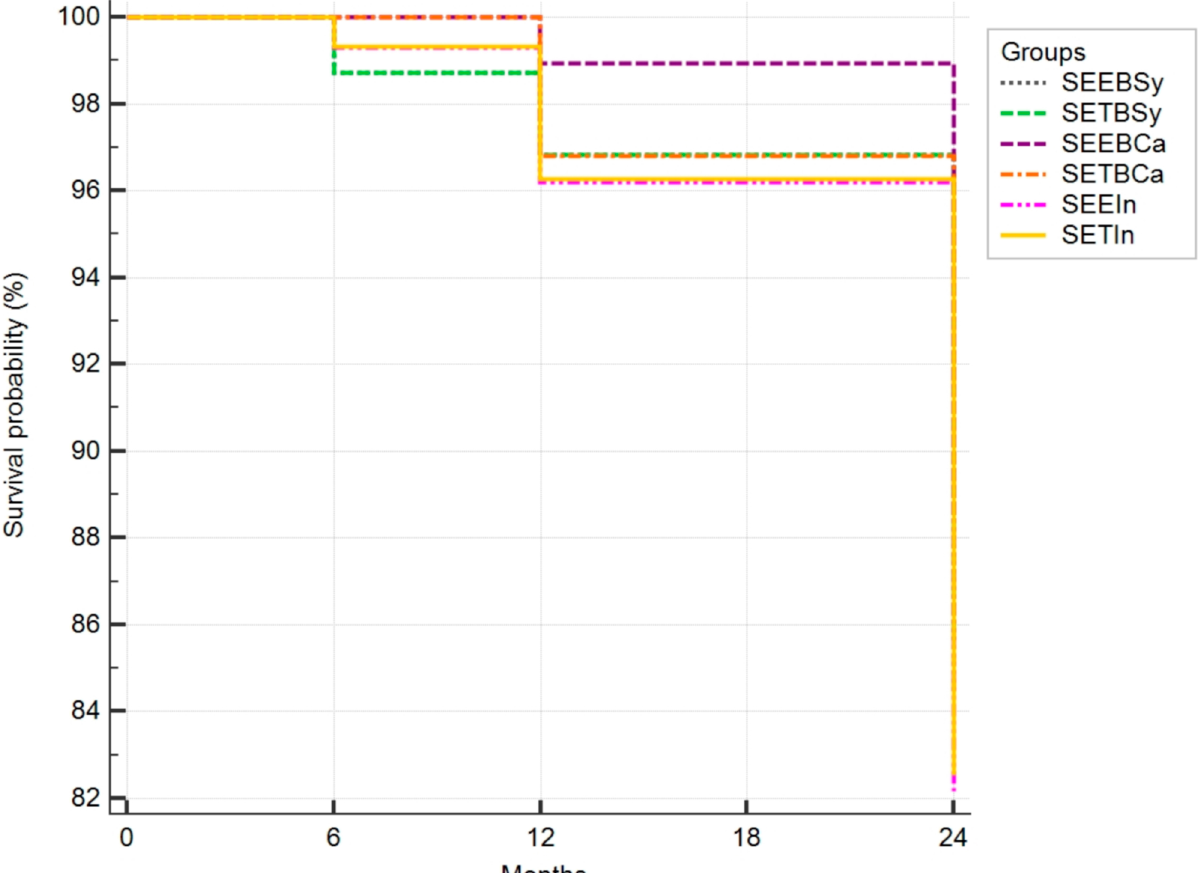
Figure 4- Survival curves for all groups. Abbreviations: SEEBSy, self-etch with selective enamel etching and bulk in syringe; SETBSy, self-etch and bulk in syringe; SEEBCa, self-etch with selective enamel etching and bulk in capsule; SETBCa, self-etch and bulk in capsule; SEEIn, self-etch with selective enamel etching and incremental composite; SETIn, self-etch and incremental